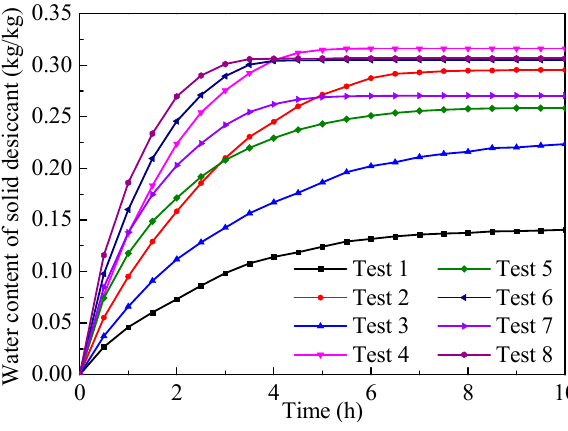
Figure 9. Variation of the water content of the whole dehumidification device with time.